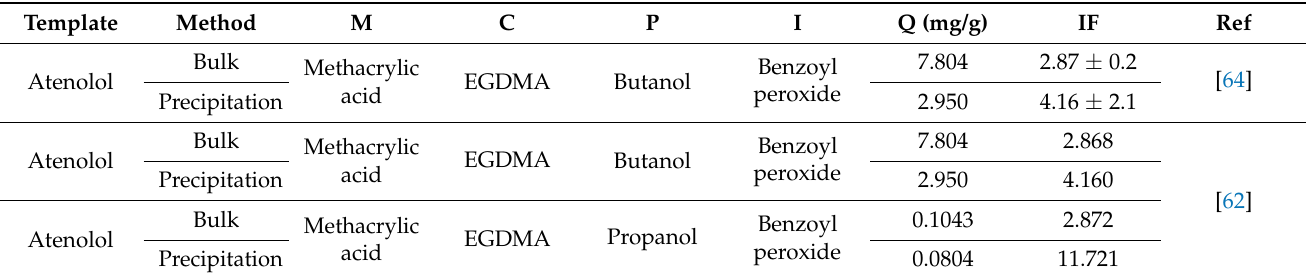
Table 6. Comparison of bulk and precipitation polymerization method in synthesis of MIP with atenolol as the